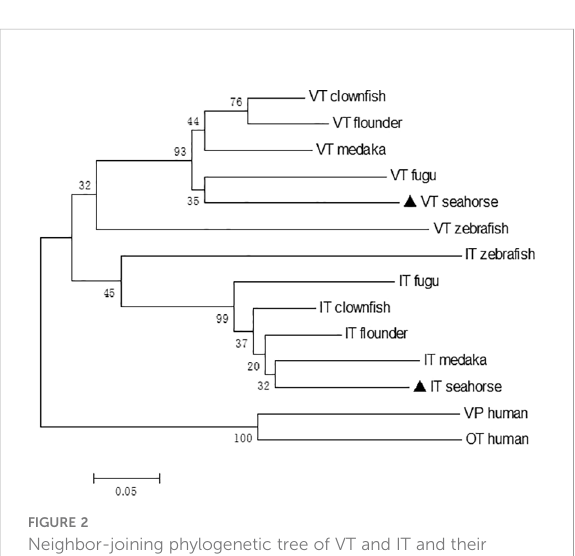
FIGURE 2 Neighbor-joining phylogenetic tree of VT and IT and their homologous sequences in vertebrates. The numbers indicate the bootstrap values of 1,000 replicates.